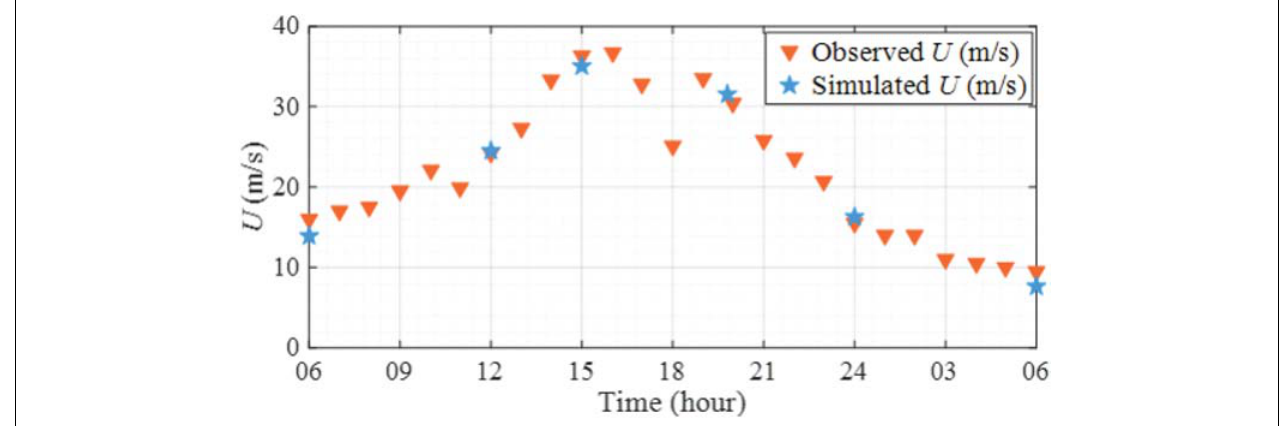
FIGURE 1 | Observed and simulated wind speeds in Hurricane Bertha